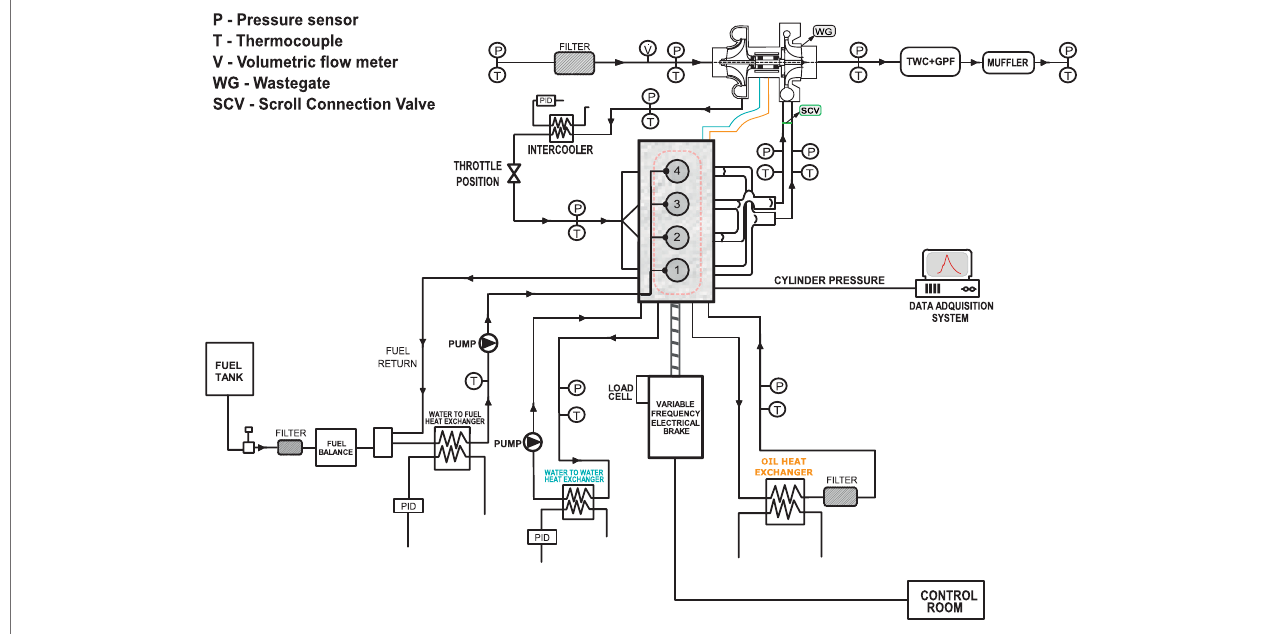
FIGURE 2 | The layout of the engine test cell and the sensor instrumentation.